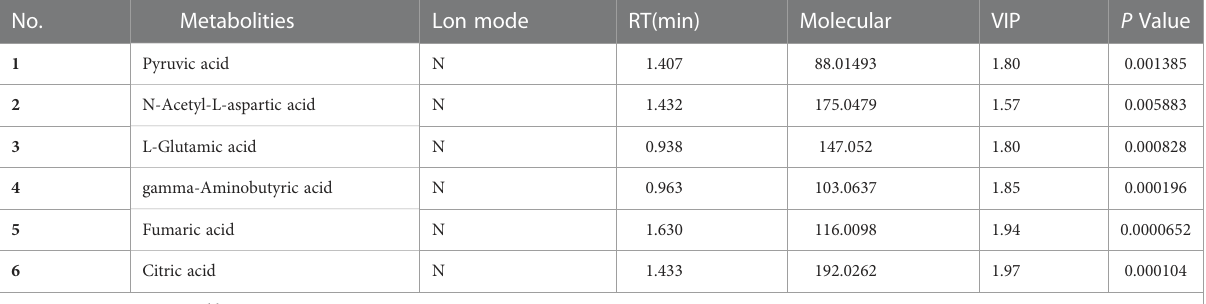
TABLE 2 Statistical analysis of potential metabolic